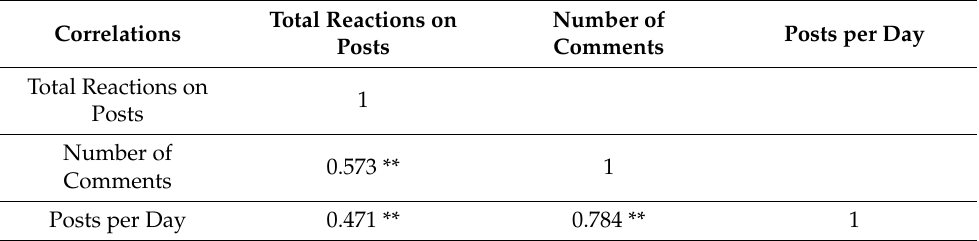
Table 4. Coefficients between the examined metrics for H2.